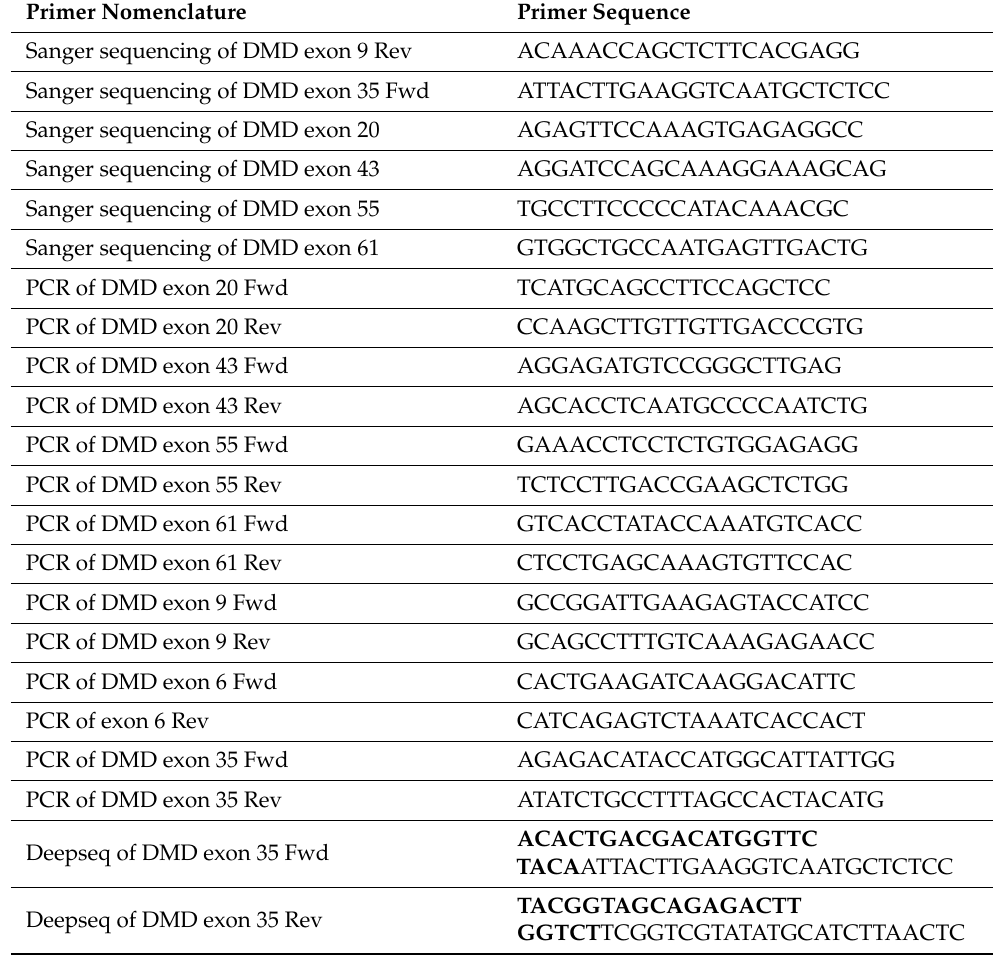
Table 1. Primer sequences for PCR, Sanger and deep